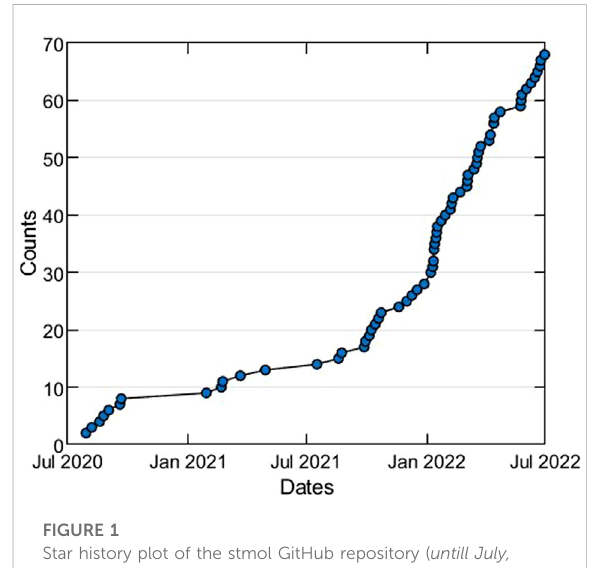
FIGURE 1 Star history plot of the stmol GitHub repository ( untill July, 2022